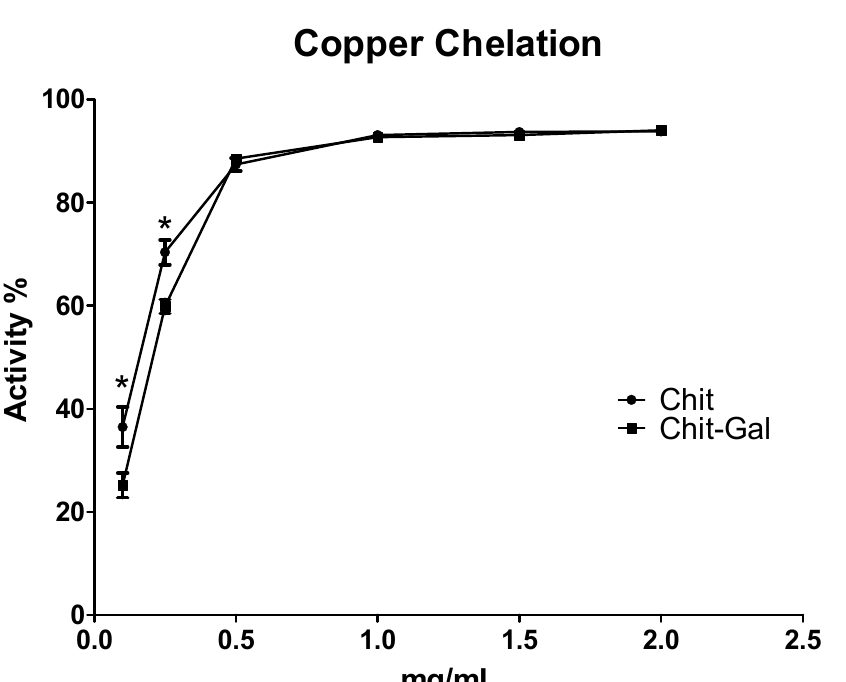
Figure 8. Activity of copper chelation of the samples. The * indicates statistically different values ( p < 0.05). EDTA was used as a positive control and had 100% activity at the concentration of 0.05 mg/mL.